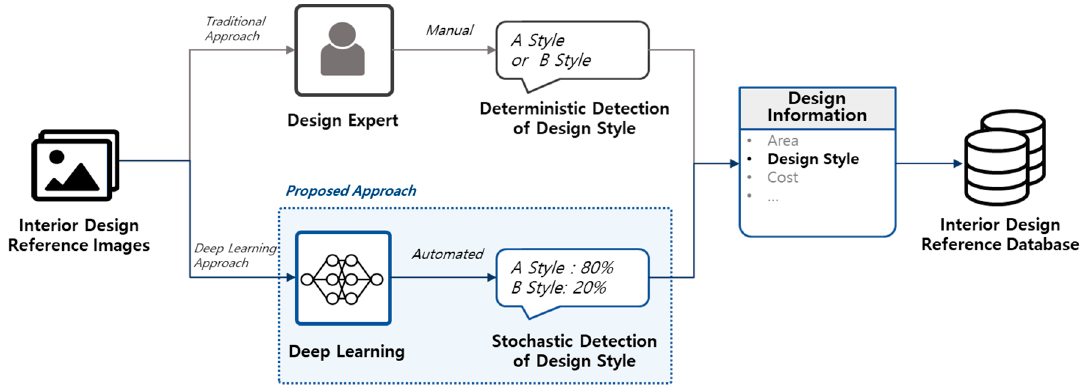
Figure 1. Research overview: deep learning-based interior design style detection for design reference.